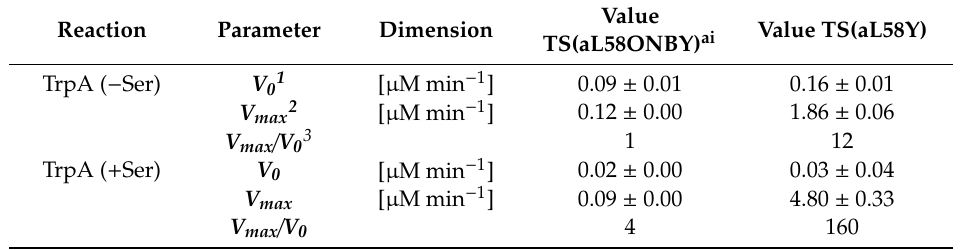
Table 3. Parameters for the stimulation of aL58ONBY ai and aL58Y by wild-type TrpB in the absence and presence of serine. Experimental data are shown in Figure 5.